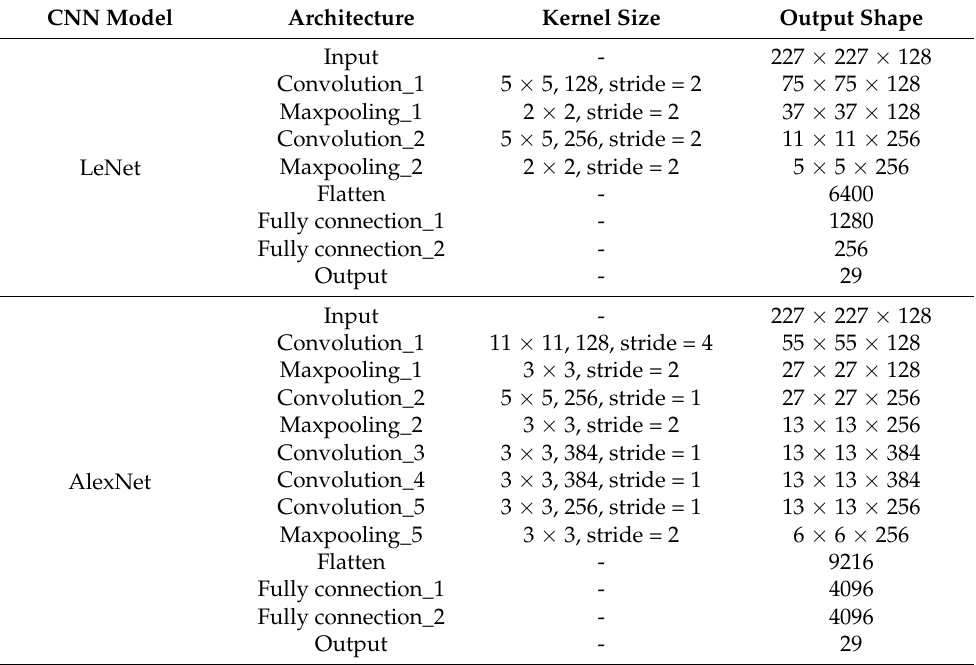
Table 2. The architecture of the LeNet and